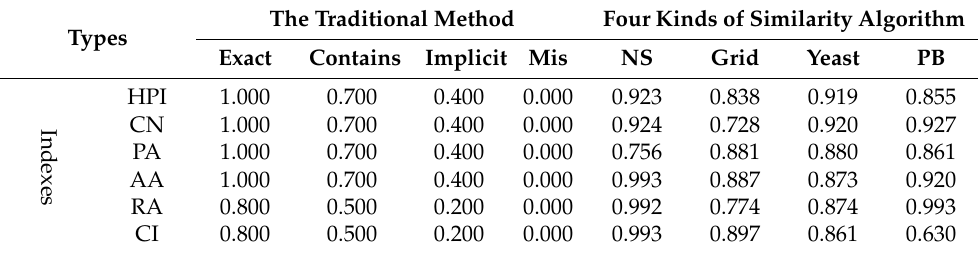
Table 8. The matching of the traditional method and 4 kinds of similarity algorithm based on a complex